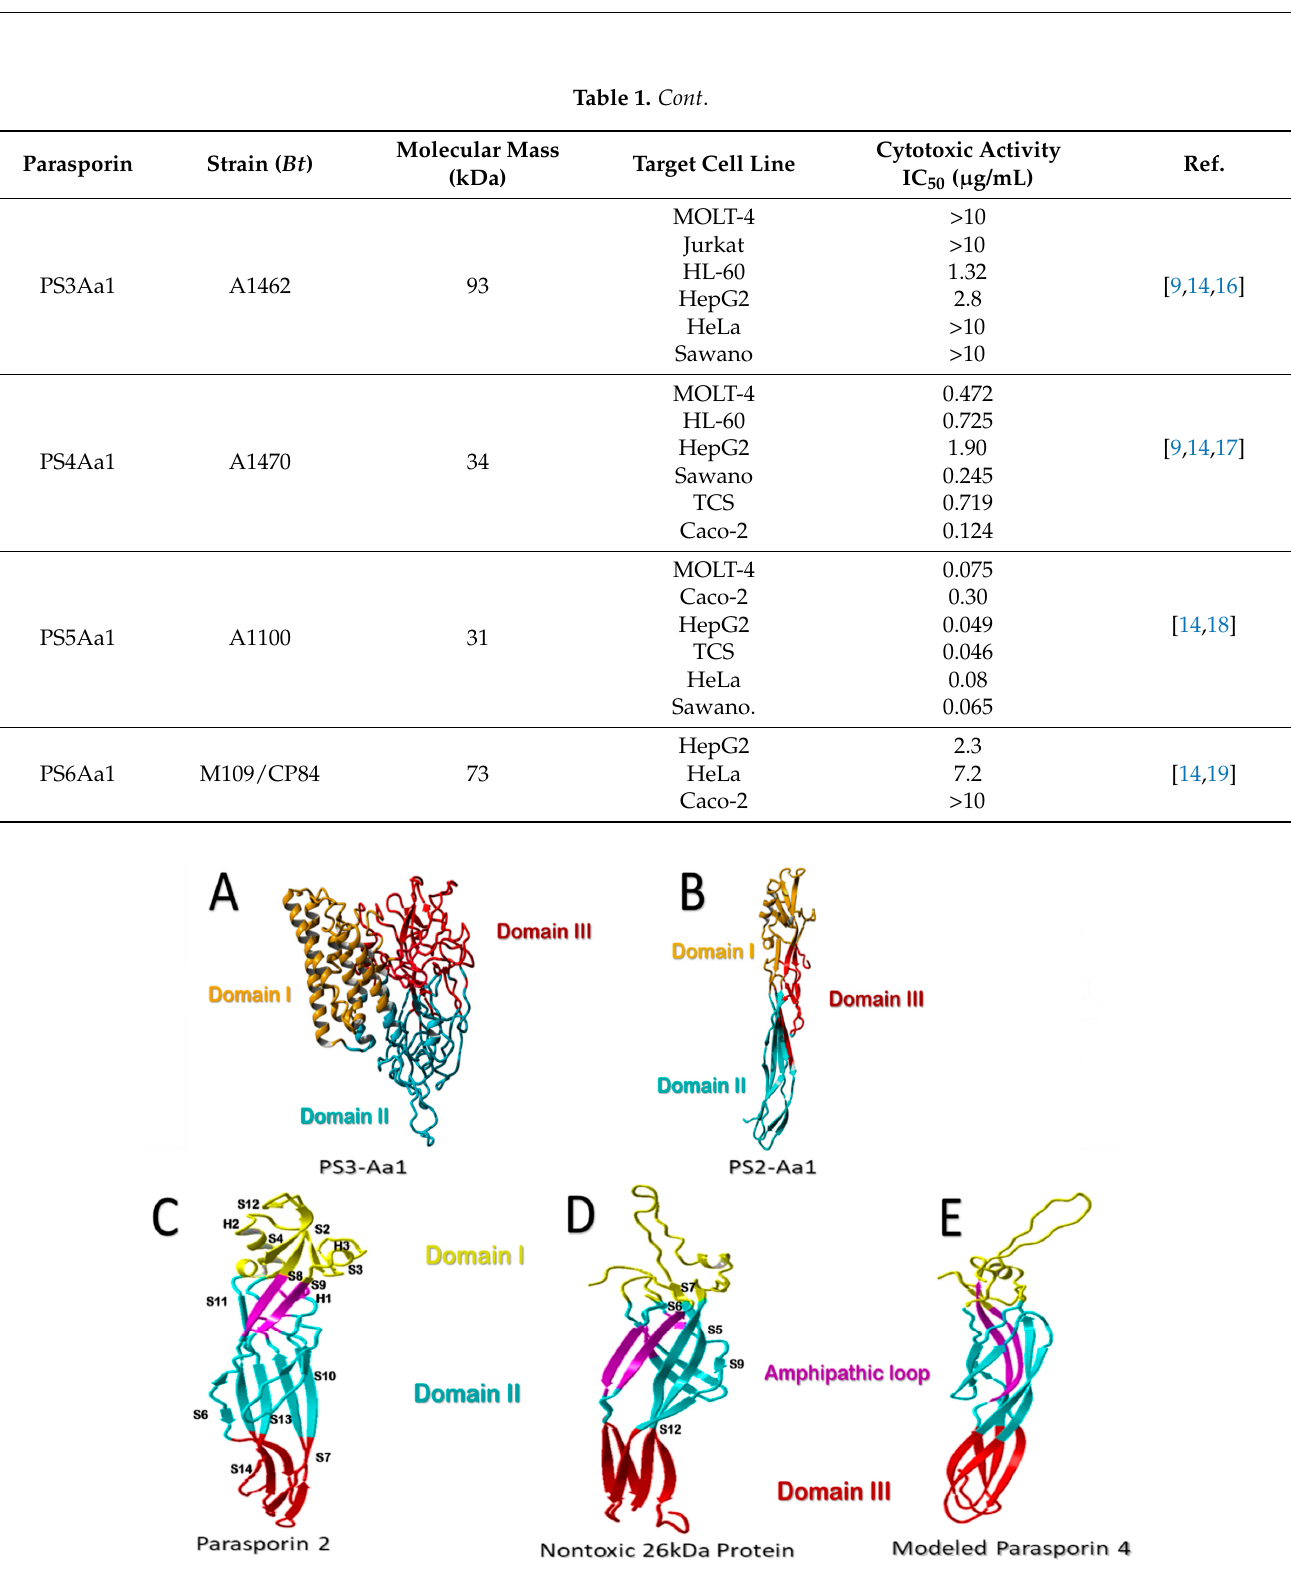
Figure 1. Structural comparison of parasporins. ( A ) Structural model of higher-molecular-weight PS3Aa1 with its three domains. ( B ) Low-molecular-weight PS2Aa1 structural model. ( C – E ) Structural comparison between parasporin-2, the 26-kDa nontoxic protein, and aerolysin-like β -PFT. Membrane-binding-related domain I is colored yellow. The membrane- insertion and pore-formation regions are colored blue (domain II) and red (Domain III). It is suggested that the purple amphipathic β -hairpin is necessary for pore formation ( C – E ). Parasporin 4 (PS4) was modeled using the 26-kDa nontoxic protein as an adapted template from Xu et al. [9], modified by the